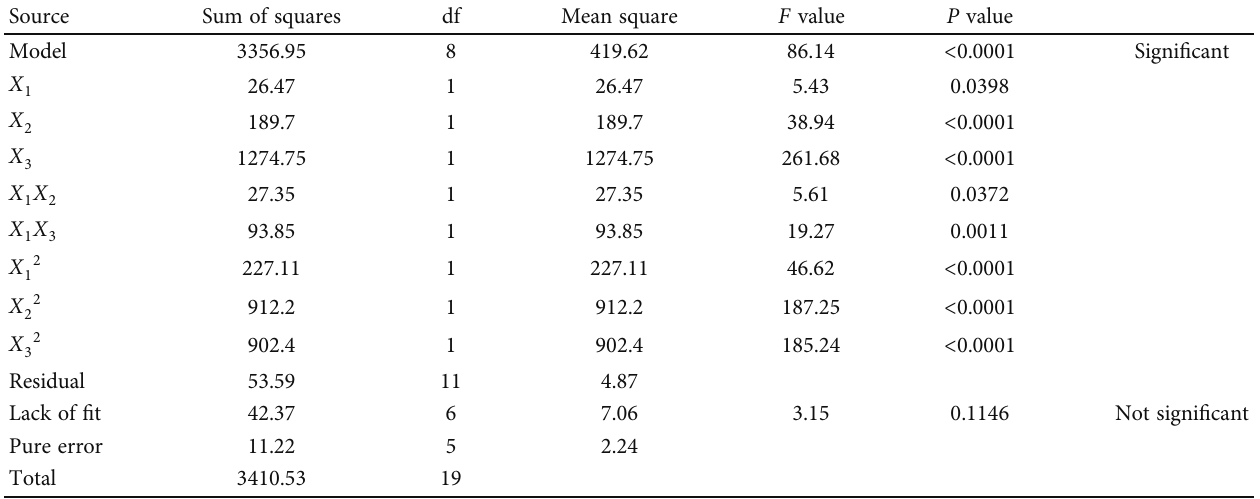
Table 8: Gadam sorghum stalks: ANOVA for testing the signi fi cance of the reduced model equation (Source: Design-Expert 13 Software). Source Sum of squares df